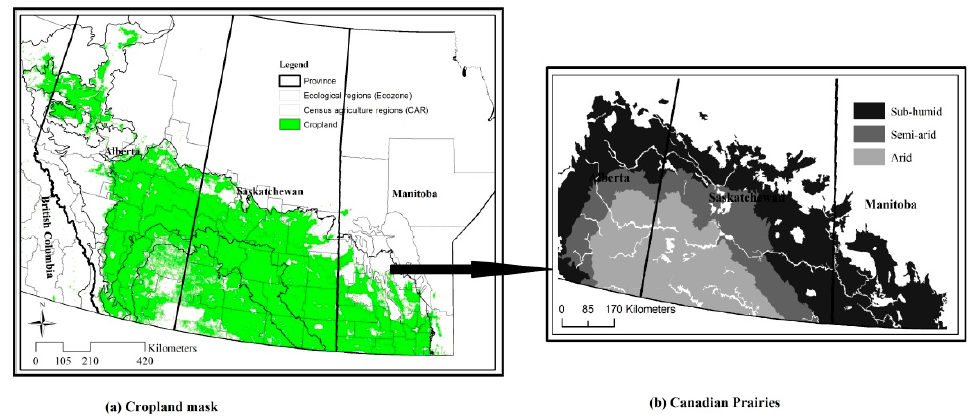
Figure 1. The general cropland mask extracted from the MODIS land cover product (MCD12Q1) ( a ) and agro-climatic zones ( b ) on the Canadian Prairies.